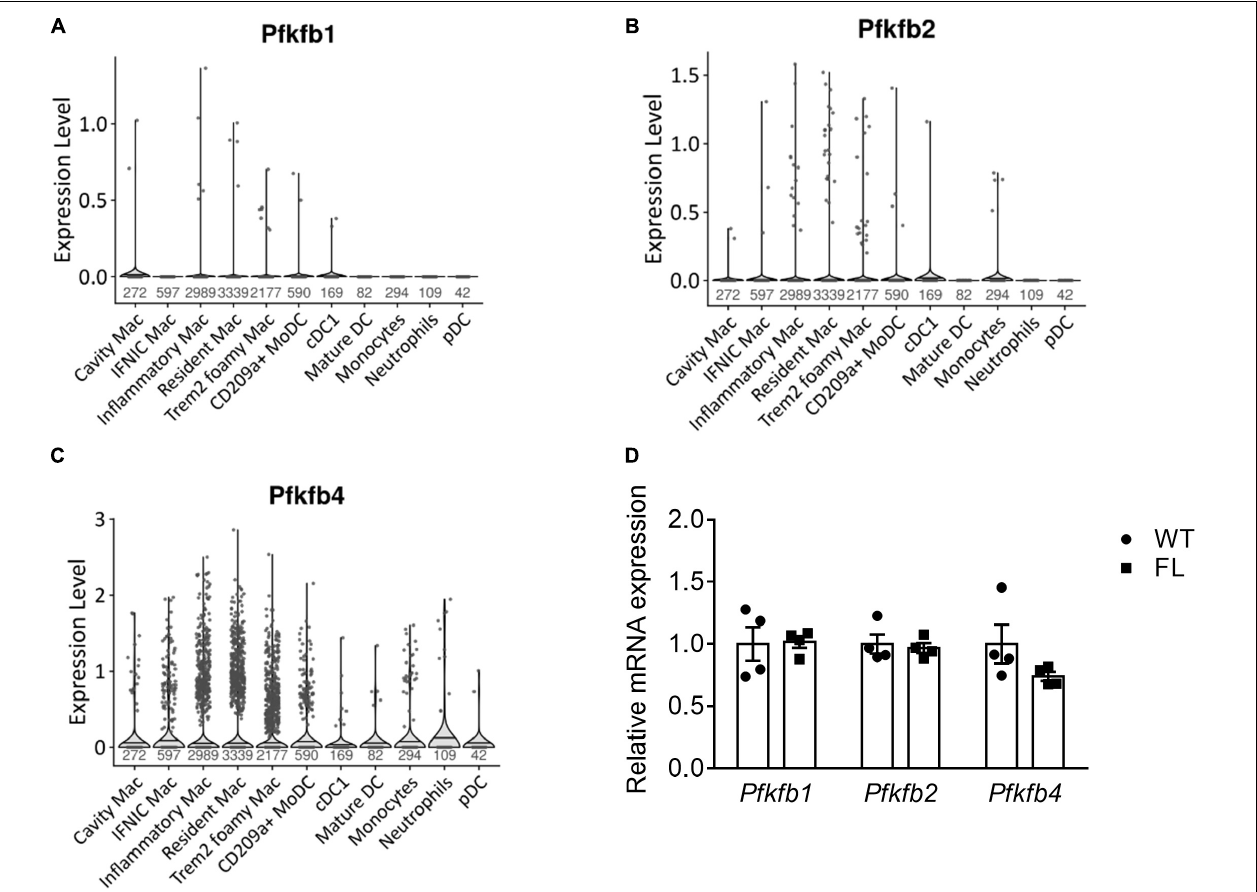
FIGURE 4 | Expression of Pfkfb isoenzymes in plaque cells. Violin plot of (A) Pfkfb1 , (B) Pfkfb2, and (C) Pfkfb4 expression in murine atherosclerotic myeloid cells (Zernecke et al., 2020). (D) Pfkfb1, Pfkfb2, and Pfkfb4 mRNA expression in Pfkfb3 fl / fl (FL) relative to Pfkfb3 wt / wt (WT) BMDMs. Data in (D) were analyzed using Two-way ANOVA. Sample sizes per cell type indicated under violin plots. CD, cluster of differentiation; cDC, conventional dendritic cell; IFNIC, interferon-inducible; Mac, macrophage; moDC, monocyte-derived dendritic cell; pDC, plasmacytoid DC; TREM2, triggering receptor expressed on myeloid cells